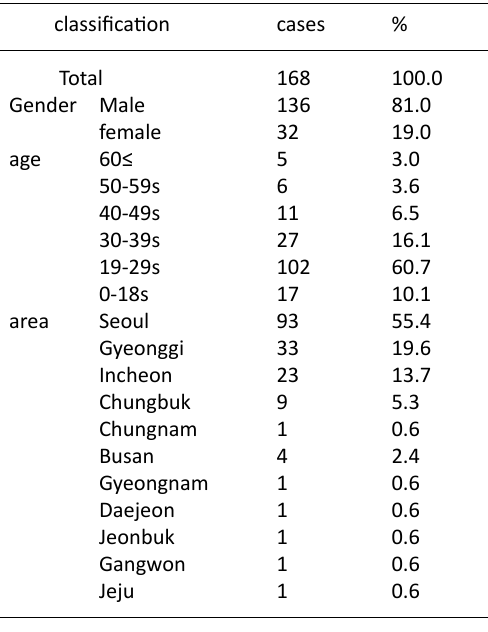
Table 1. Status of COVID-19 infection in relation to